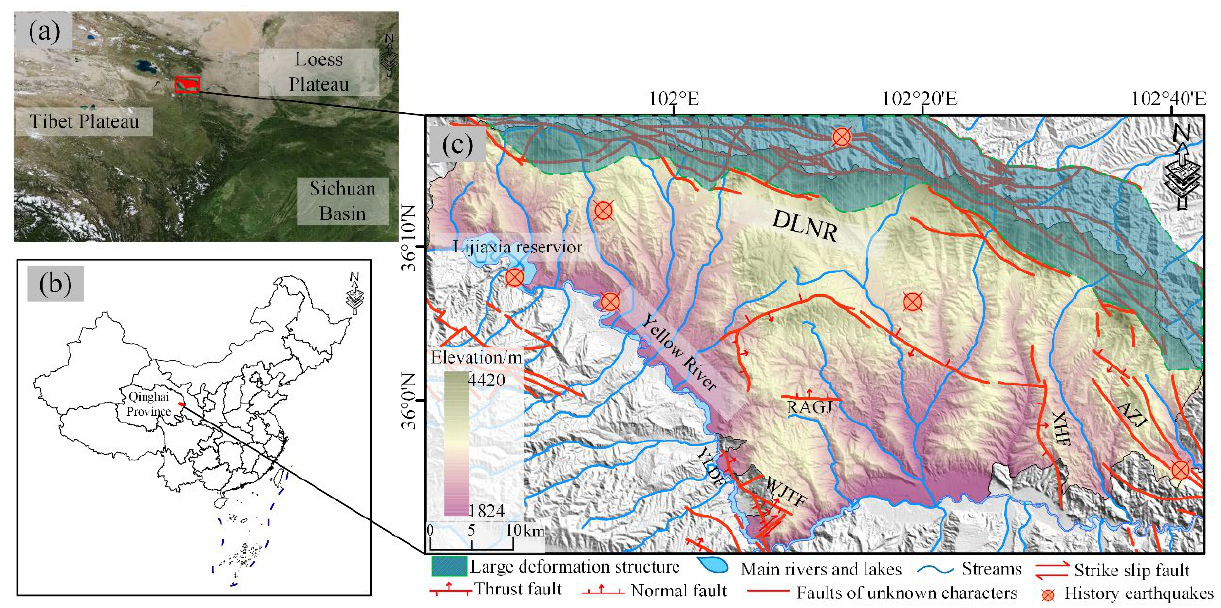
Figure 1. Topographic map of the study area showing major faults and earthquakes. ( a , b ) Location map of the study area. ( c ) Regional tectonic map of the study area. The base map of ( a ) is derived from Google Earth. The base map of ( b ) is derived from https://www.webmap.cn/ (accessed on 15 October 2022). The water system data in ( c ) are derived from https://www.webmap.cn/ (accessed on 15 October 2022). Historical earthquake data were obtained from https://data.earthquake.cn (accessed on 15 October 2022). Faults data were obtained from http://dcc.cgs.gov.cn/ (accessed on 15 October 2022).